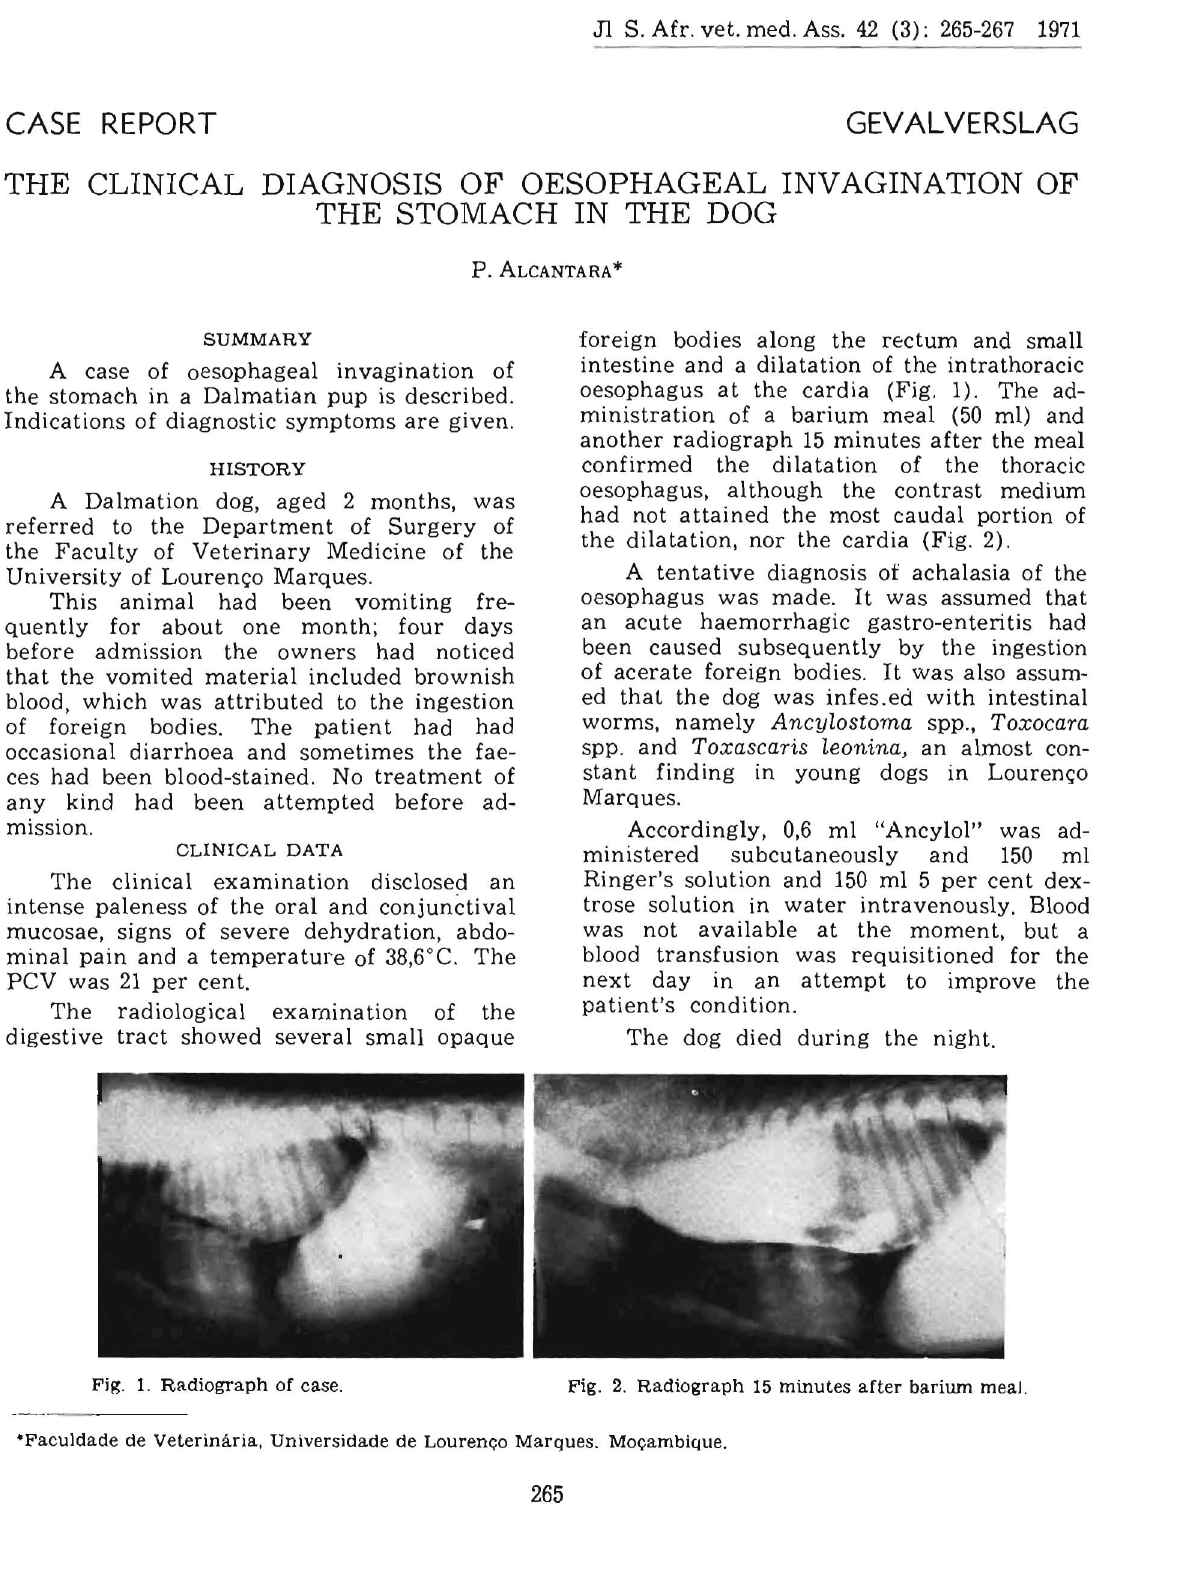
Fig. 1. Radiograph of case. Fig. 2. Radiograph 15 minutes after barium